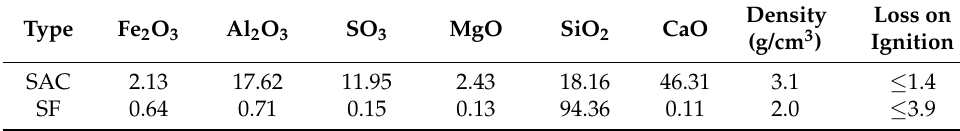
Table 2. Chemical composition of SAC and SF (wt%).